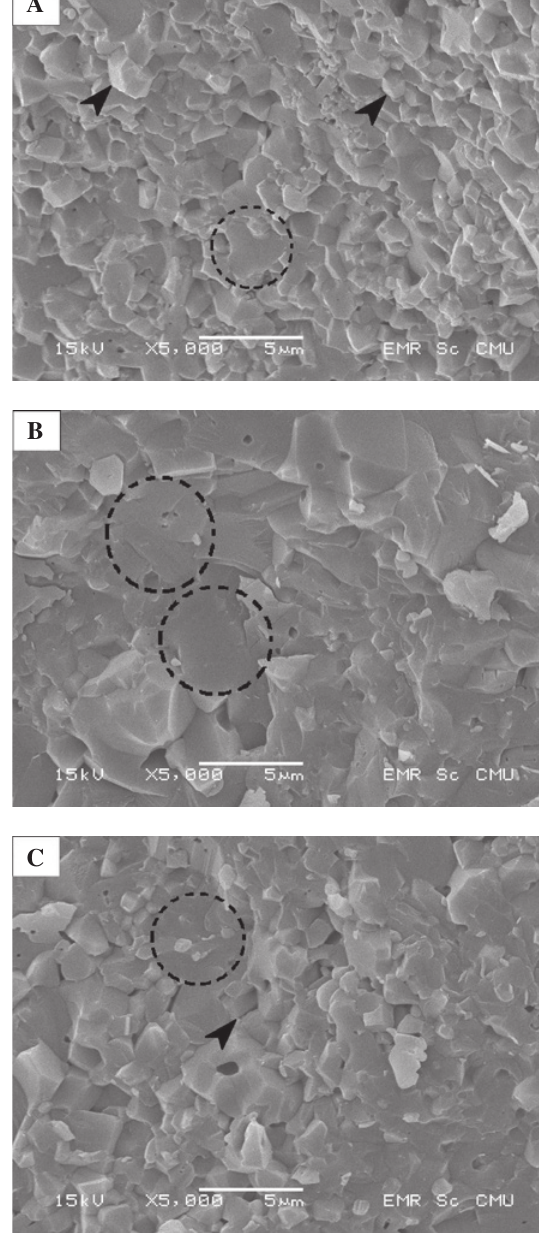
Figure 4: Fracture surfaces of alumina and alumina/mullite composites at 1550 ° C: (A) alumina (A55), (B) alumina/mullite from alumina and SiO (ASO55), and (C) alumina/mullite from alumina 2 and SiC (ASC55). The arrow indicates intergranular fracture and the area in dotted circle indicates transgranular